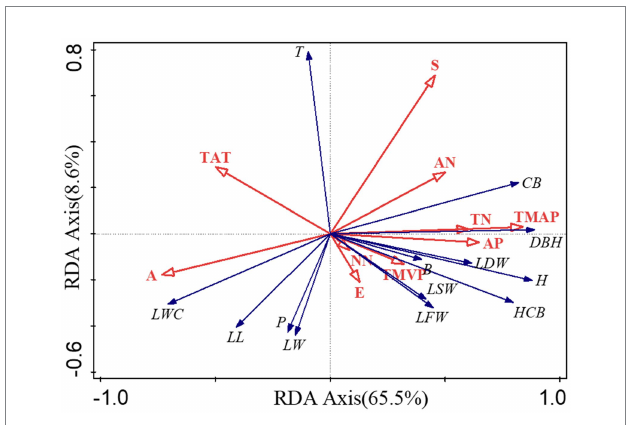
FIGURE 2 RDA analysis of habitat factors and growth factors of B. ceiba. Note: H: